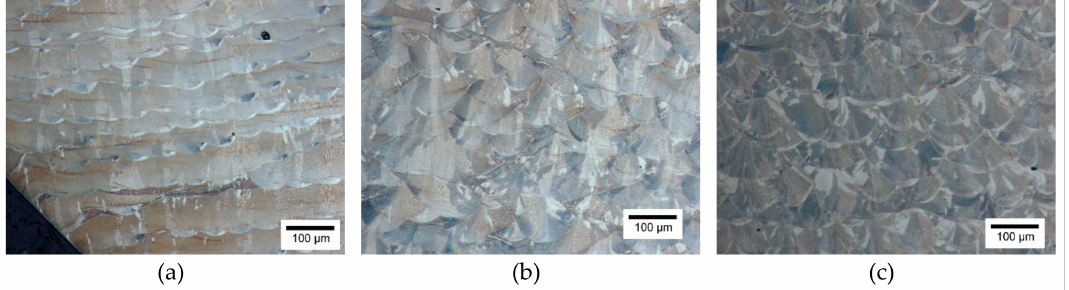
Figure 5. Microstructure side-by-side comparison of ( a ) 0 ◦ , ( b ) 67 ◦ , and ( c ) 105 ◦ hatch angle specimens built in the y-direction before compression test. Electrolytic etchant in 60:40 nitric acid:water